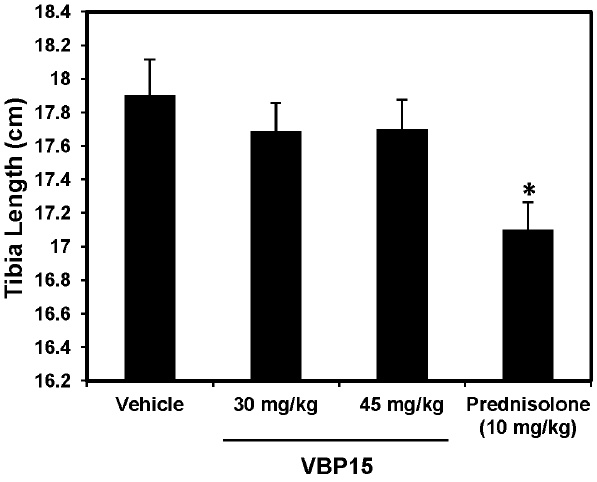
Figure 7. VBP15 does not induce tibia length shortening. Wildtype outbred CD1 mice were treated daily for 5 weeks with VBP15 (30 and 45 mg/kg), prednisolone (10 mg/kg) or vehicle control starting at 12 days of age. At the end of the treatment, tibias were harvested and measured. Bar graph represents mean ( 6 SE) tibia length values. *p , 0.05 compared to vehicle control with n=10